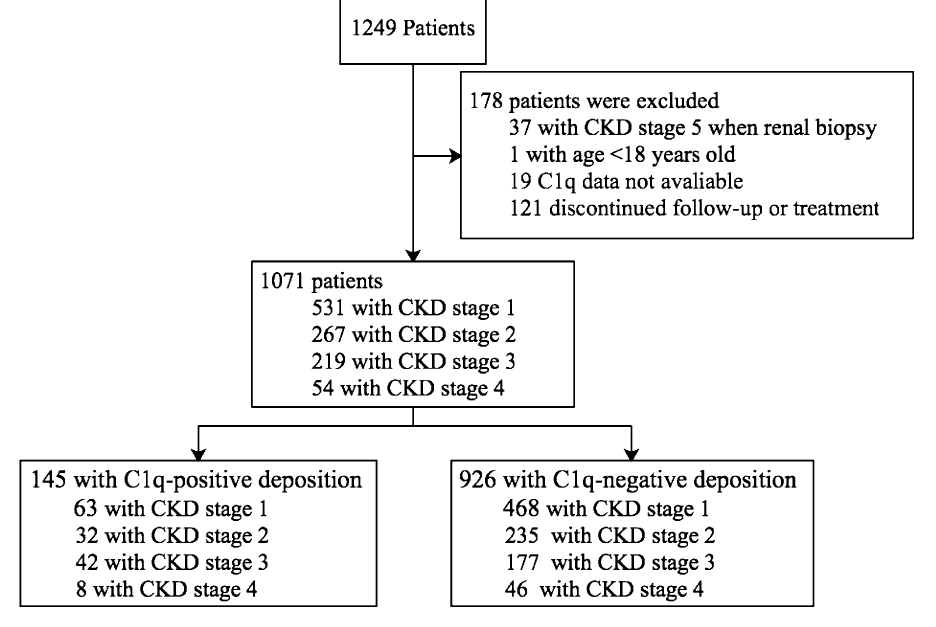
Figure 1. Study profile. CKD chronic kidney